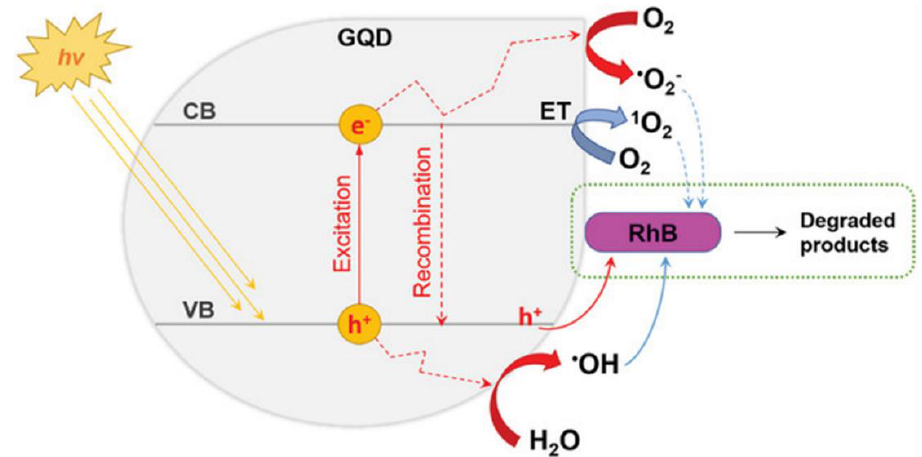
Figure 7. Proposed photodegradation mechanism of a pollutant, RhB, by CDs. Reproduced with authorization from [93] .